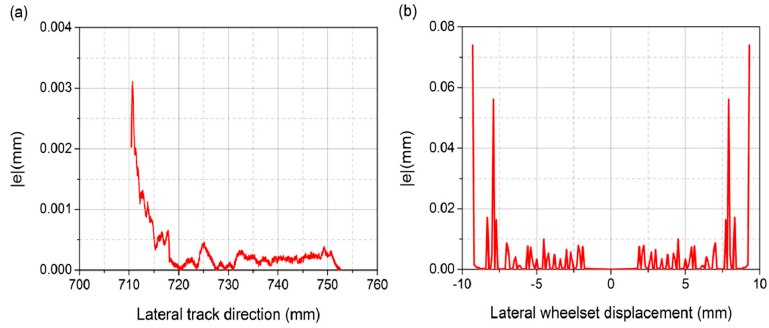
Figure 9. Absolute value of the error e . ( a ) wheel profile; ( b ) rolling radii difference distribution.